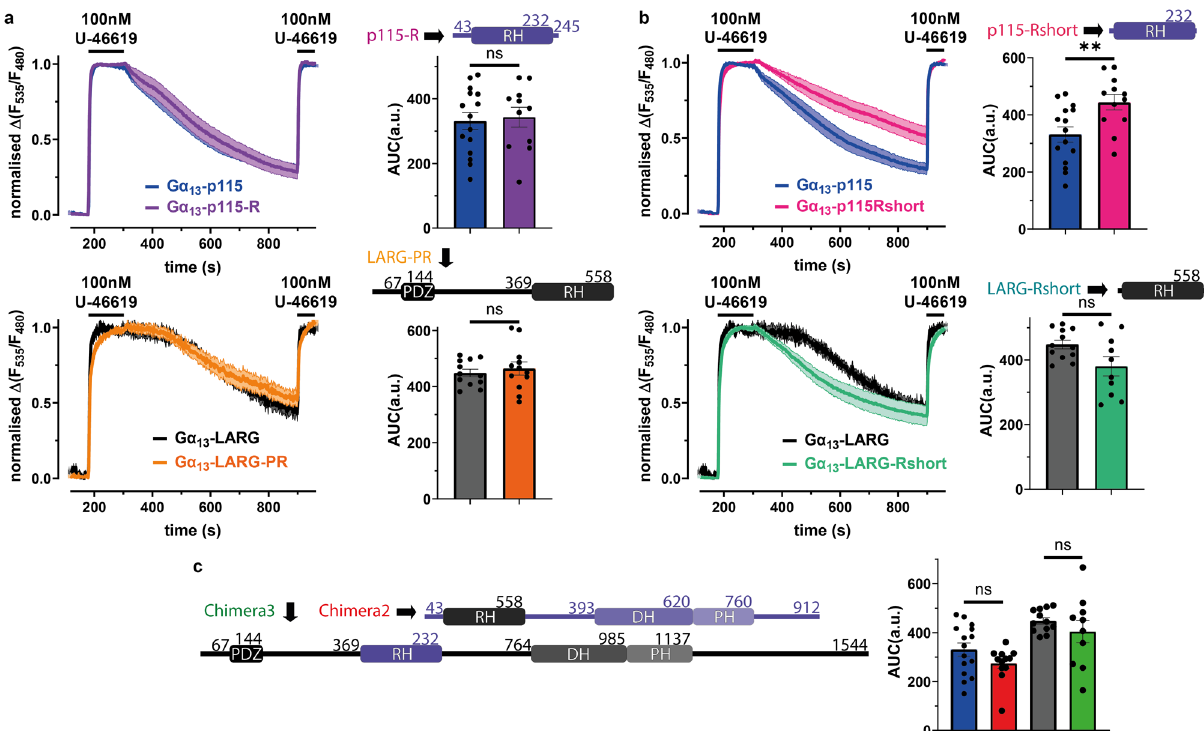
Fig. 4 The region of p115 N-proximal to the start of the RH domain is required for distinct interaction kinetics with G α 13 . a p115-RhoGEF was truncated at the C-terminal end behind the RH domain to create p115-R (purple, amino acids 1-245, -R means containing the RH domain), while LARG-PR (orange, amino acids 1-558, -PR means containing the PDZ and RH domains) was created the same way. Truncation of p115 [blue, data from Fig. 2c] did not show a signi fi cant difference in the AUC of decay (as described in Fig. 2c) [p115-R: purple, n = 11, mean AUC = 342.9, unpaired t-test, ns P = 0.7734] upon agonist stimulation. The same was true for the truncated version of LARG [black, n = 12, data from Fig. 2c vs LARG-PR: orange, n = 12, mean AUC = 464.2, unpaired t -test, ns P = 0.5571] b Additional N-terminal parts were removed to create p115-Rshort (pink, amino acids 34-235) and LARG-Rshort (turquoise, amino acids 360-561). Although LARG-Rshort [turquoise, n = 10, mean AUC = 380.2] revealed no signi fi cant kinetical difference to wt-LARG [black, data from Fig. 2c, unpaired t -test with Welch´s correction, ns P = 0.0578], the AUC of the G α 13 -p115-Rshort [pink, n = 12, mean AUC = 443.9] interaction was signi fi cantly larger than for wt-p115 [blue, data from Fig. 2c, unpaired t -test, ** P = 0.0069] c Chimera 2 [red, n = 12, mean AUC = 273.5, unpaired t -test, ns P = 0.1116], a full length p115 (amino acids 1-912) containing the RH domain of LARG (amino acids 370-558), did not display a signi fi cant difference compared to wt-p115. Chimera 3 [green, n = 10, mean AUC = 404.2, unpaired t-test with Welch´s correction, ns P = 0.3828], a full length LARG (amino acids 1-1544) containing the RH domain of p115 (amino acids 44-232), did not present a signi fi cant difference compared to